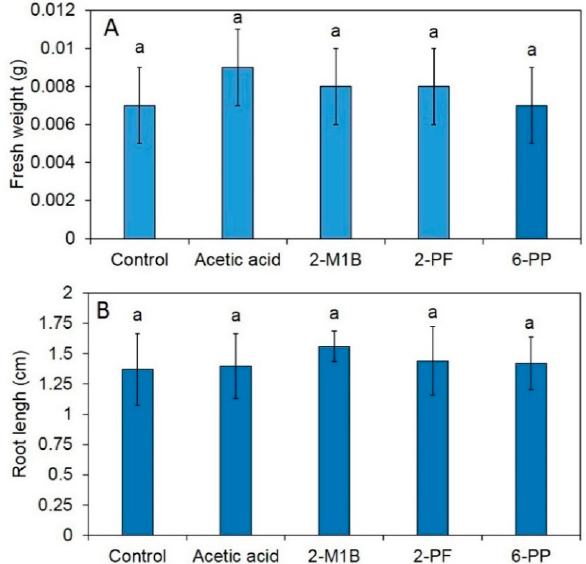
Figure 9. E ff ects of volatile organic compounds on the phenotypic characteristics of fresh weight ( A ) and root length ( B ) of A. thaliana . Di ff erent letters indicate statistically significant di ff erences among treatments ( p < 0.05) using the Tukey’s